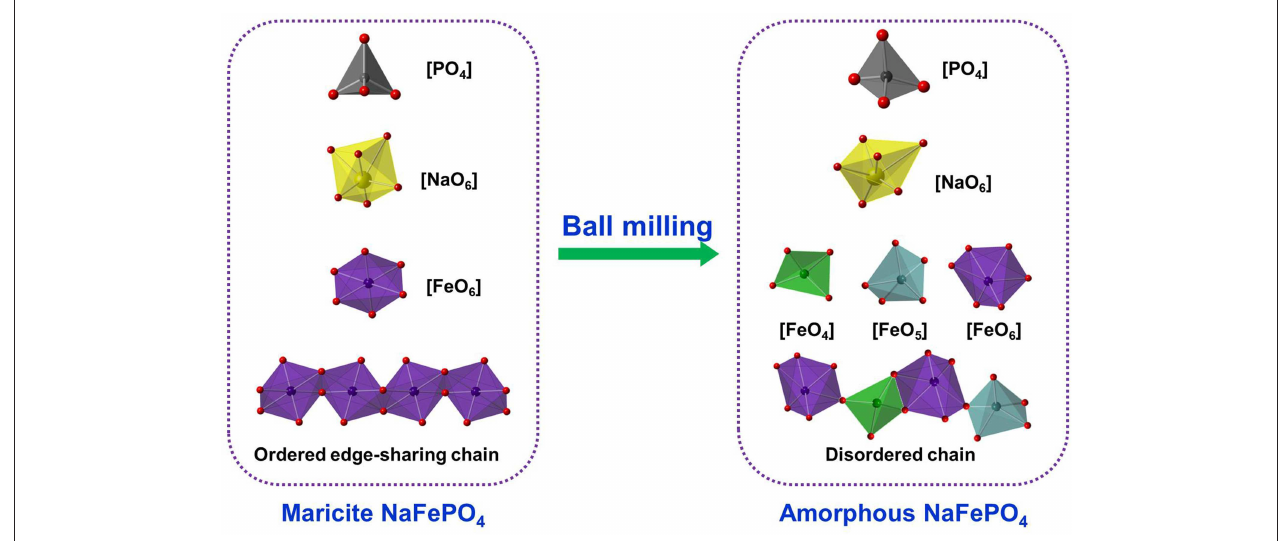
FIGURE 1 | Structural evolution of network forming motifs and intermediate range cationic order from maricite-type to amorphous NaFePO 4